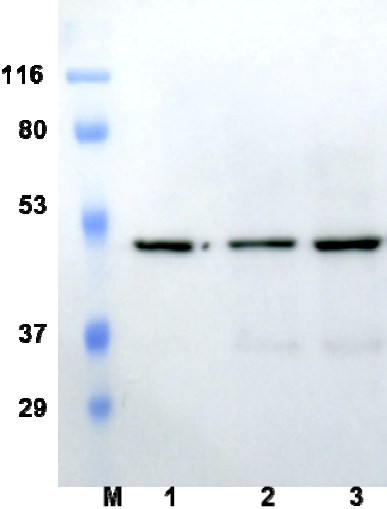
Figure 1. Western blot results of recombinant NS2B-NS3 pro after 48, 72, and 96 h of expression. Lane M, markers; lanes 1, 2, and 3, western blots conducted after 48, 72, and 96 h expression,